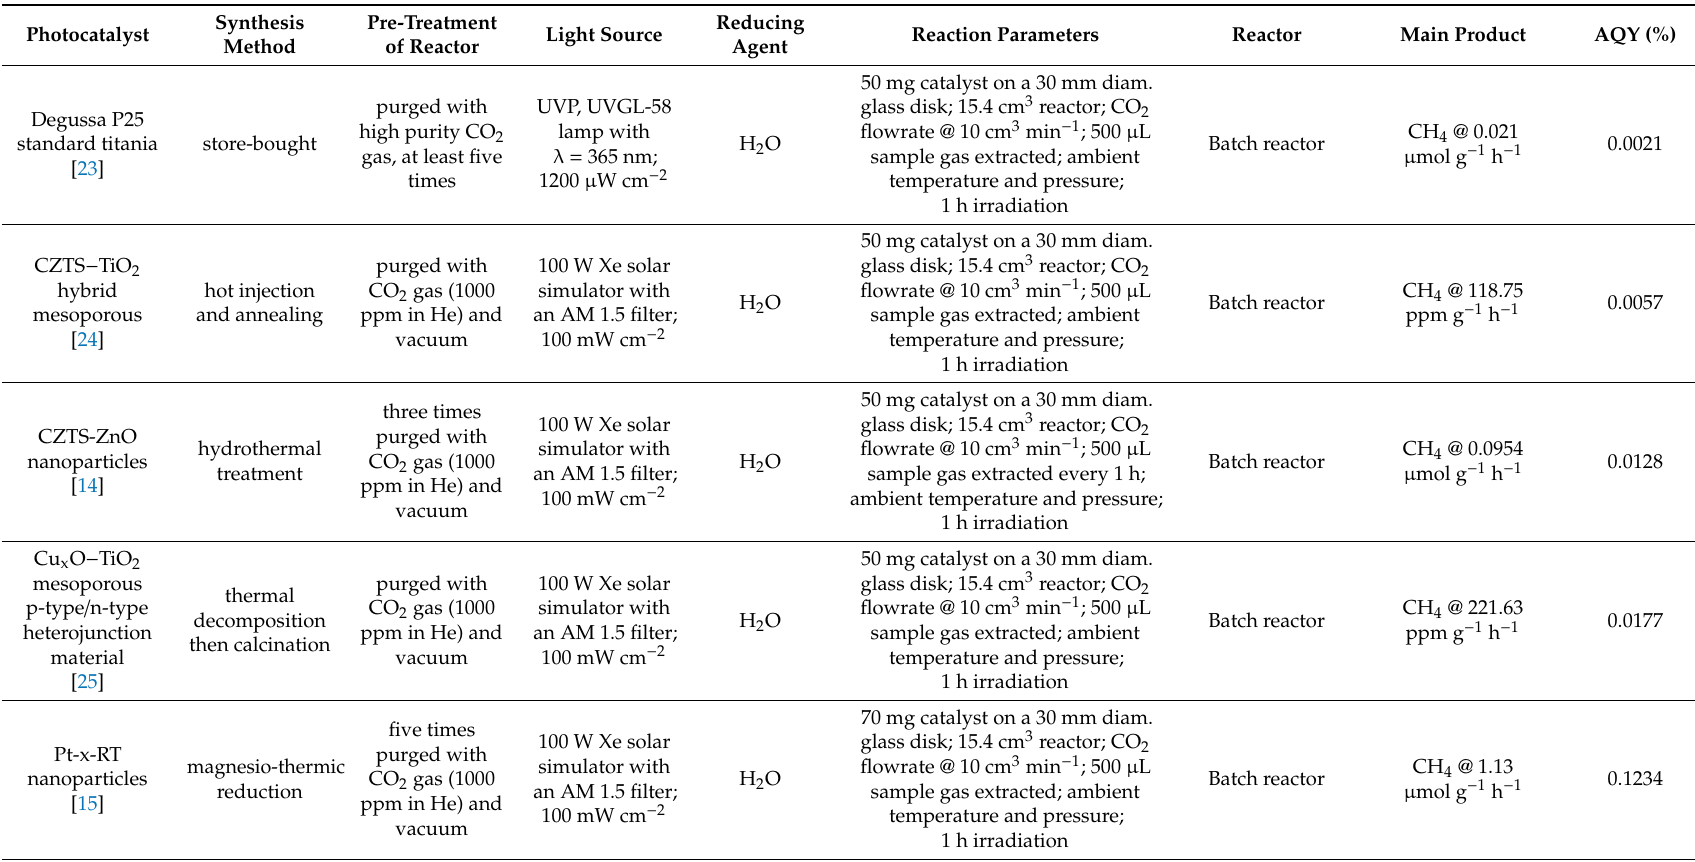
Table 1. Summary of operating parameters and yields reported by In et al. for photocatalytic CO 2